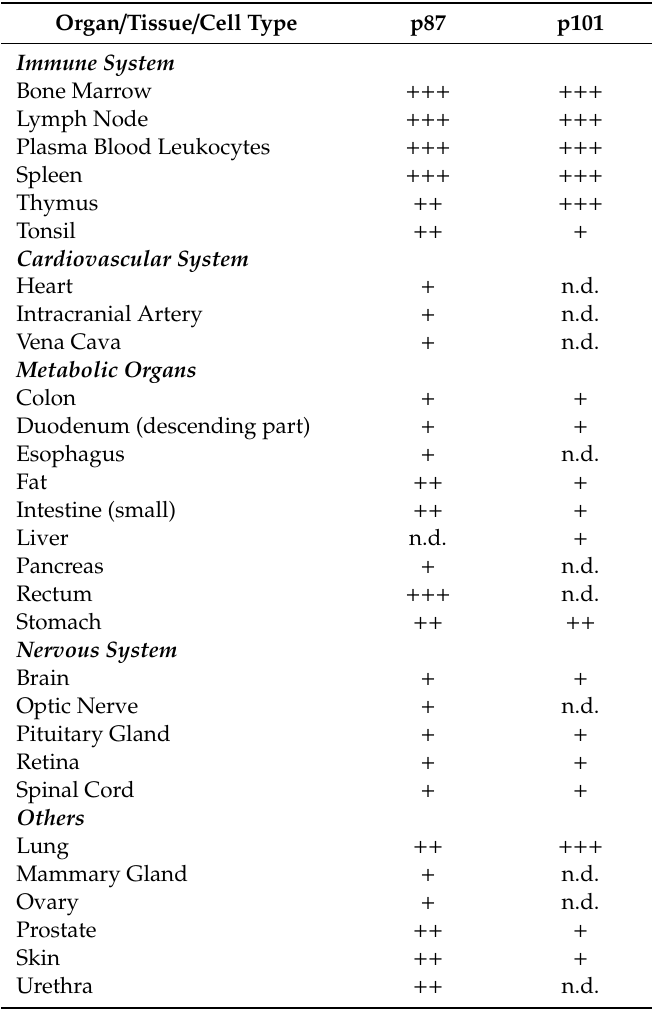
Table 1. Transcript distribution of PI3K γ subunits p87 and p101 in human tissue and organs expressing p110 γ (data taken from Reference [33]). The ratio of p87 or p101 mRNA to GAPDH mRNA is depicted: not detected (n.d.) < 0.001; + 0.001 to 0.005; ++ 0.005 to 0.01; +++ > 0.01. Organ / Tissue / Cell Type p87